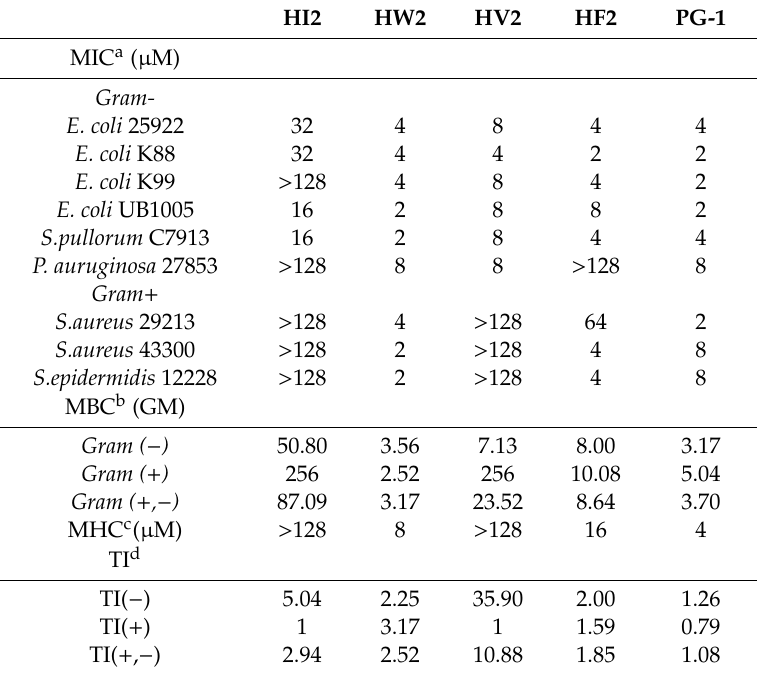
Figure 2. The CD spectra of the peptides. The peptides were dissolved in 10 mM sodium phosphate buffer (pH 7.4) (Blue line), 30 mM SDS (Red line) and 50% TFE (Green line). The mean residue ellipticity was plotted against wavelength. The values from three scans were averaged per sample, and the peptides concentrations were fixed at 150 μ M.